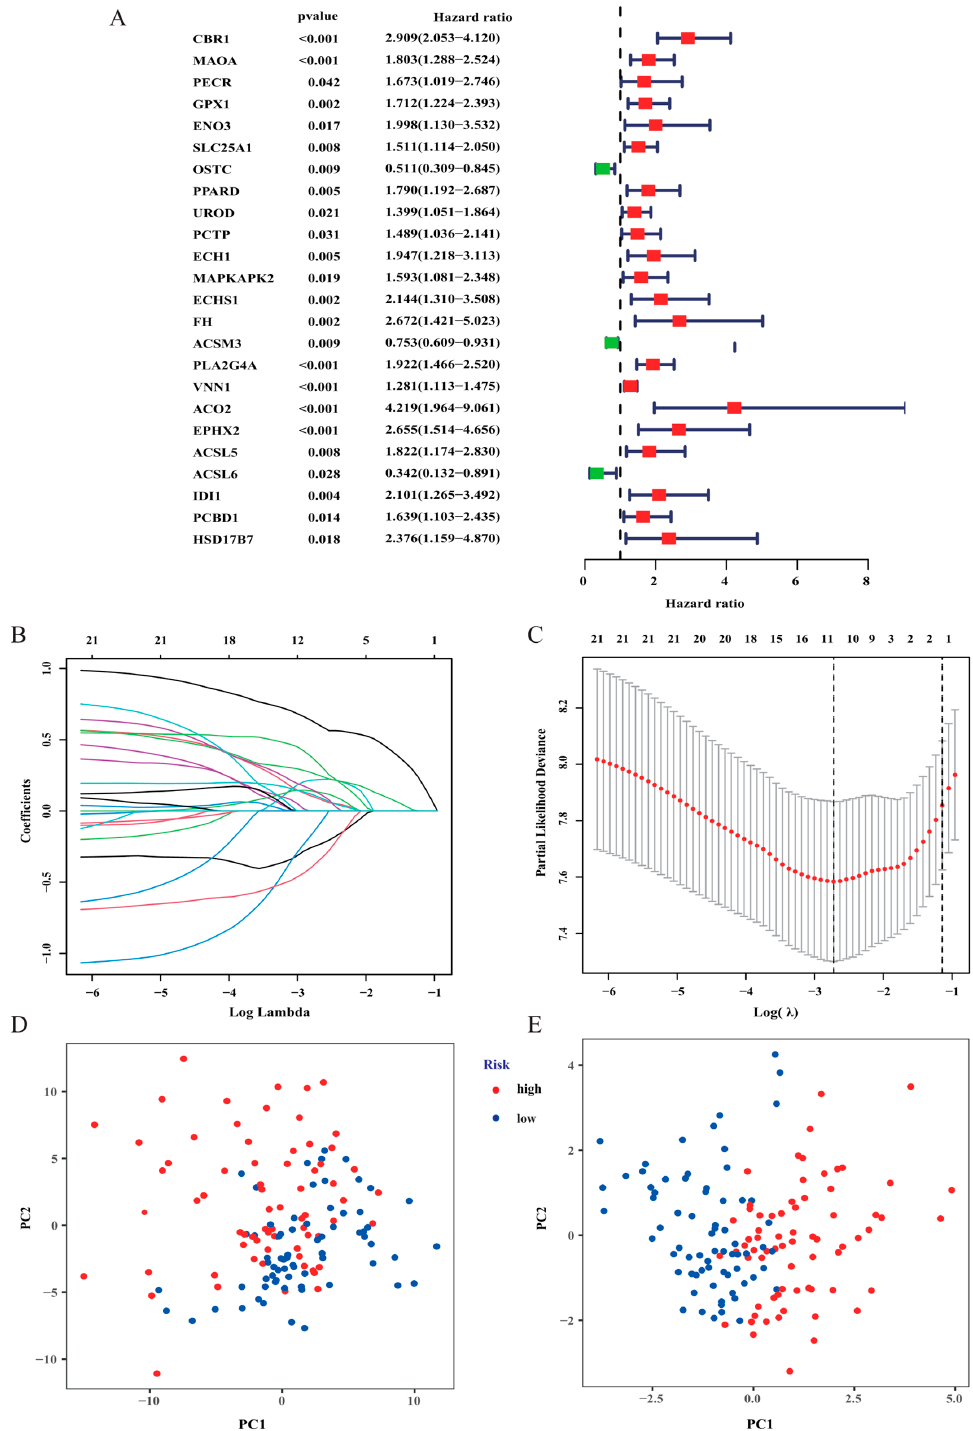
Figure 3. Construction of the prognostic risk model. ( A ) Forest plot of 24 fatty acid metabolism-related genes associated with prognosis identified using univariate Cox regression analysis. ( B , C ) LASSO Cox regression was performed to identify fatty acid metabolism-related genes closely associated